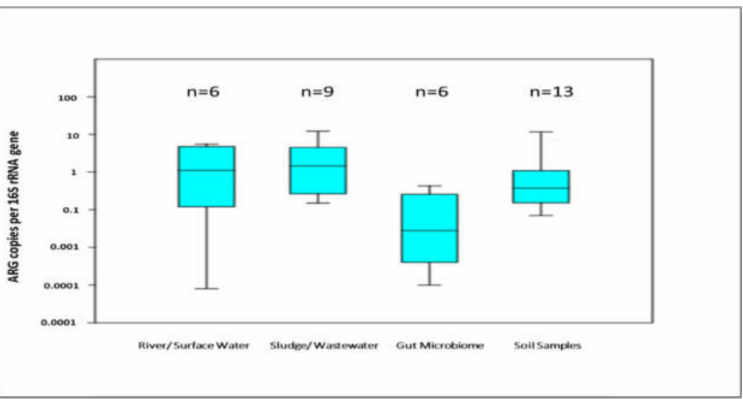
Figure 5. Box and whisker plot depicting the log transformed ARG copies per 16S rRNA gene for different environmental samples, ( n ) represents no. of